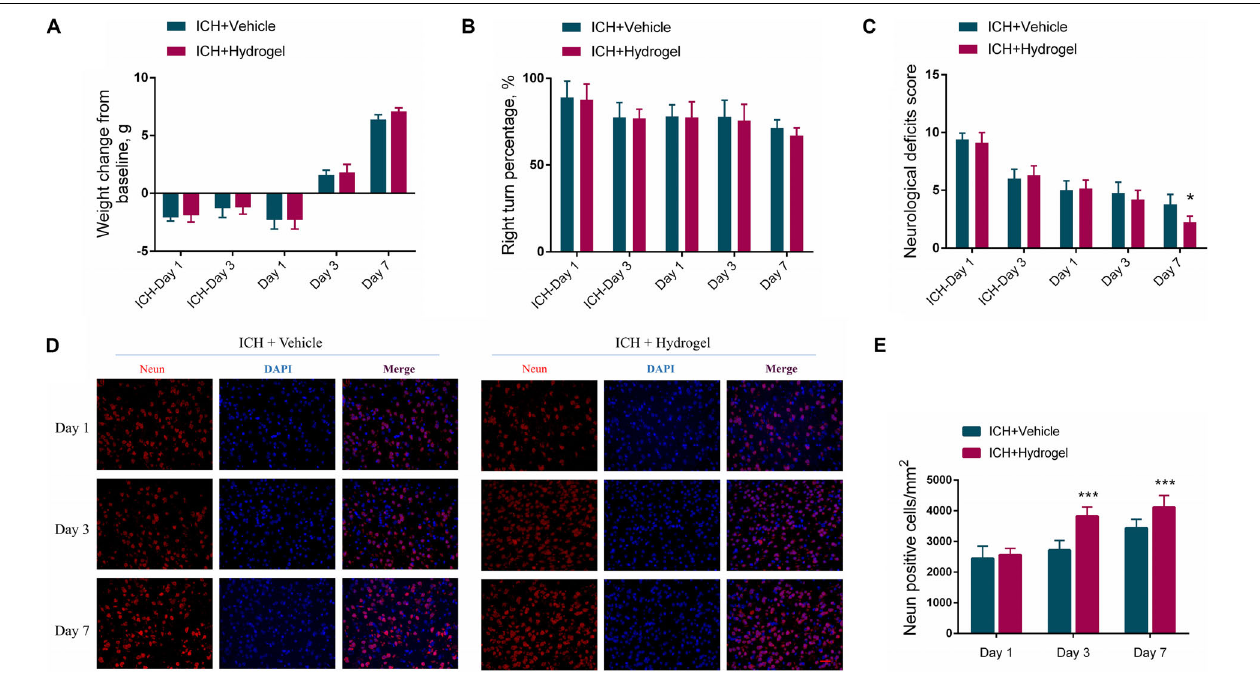
FIGURE 3 | (A) Body-weight change. (B) The statistical graph of the corner turn test. (C) The statistical graph of the neurological deficit testing. (D) Representative images for Immunofluorescence staining of neuron marker Neun, scale bar = 20 µ m. (E) The statistical graph of the Neun positive cells. Data are present as mean ± SD ( n = 4), * P < 0.05, *** P <